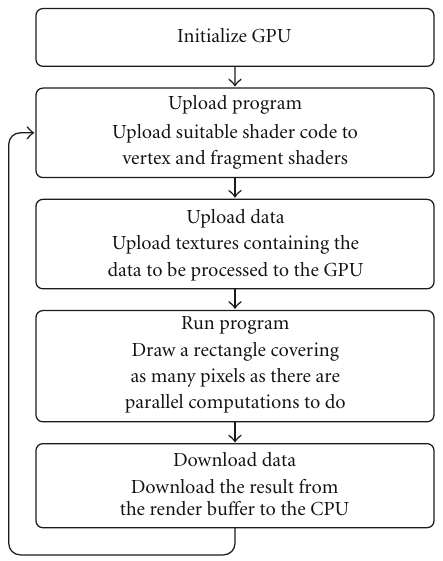
Figure 2: Work flow for GPGPU programming using the OpenGL shading language